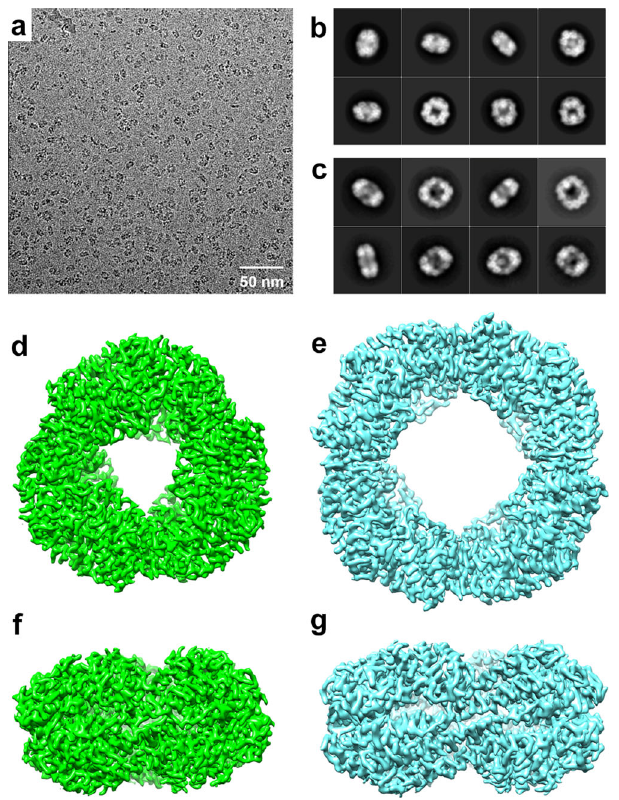
Fig. 3 Cryo-EM analyses of Tl CPC-6 and Tl CPC-8. Representative motion- corrected electron micrograph of Tl CPCs ( a ). Typical reference-free 2D class averages from single-particle images of Tl CPC-6 ( b ) and Tl CPC-8 ( c ). Top and side views of cryo-EM density maps of Tl CPC-6 at 3.06 Å resolution ( d and f ) and Tl CPC-8 at 3.71 Å resolution ( e and g ). Contour levels of Tl CPC-6 and Tl CPC-8 are shown at 0.06 and 0.04, respectively.